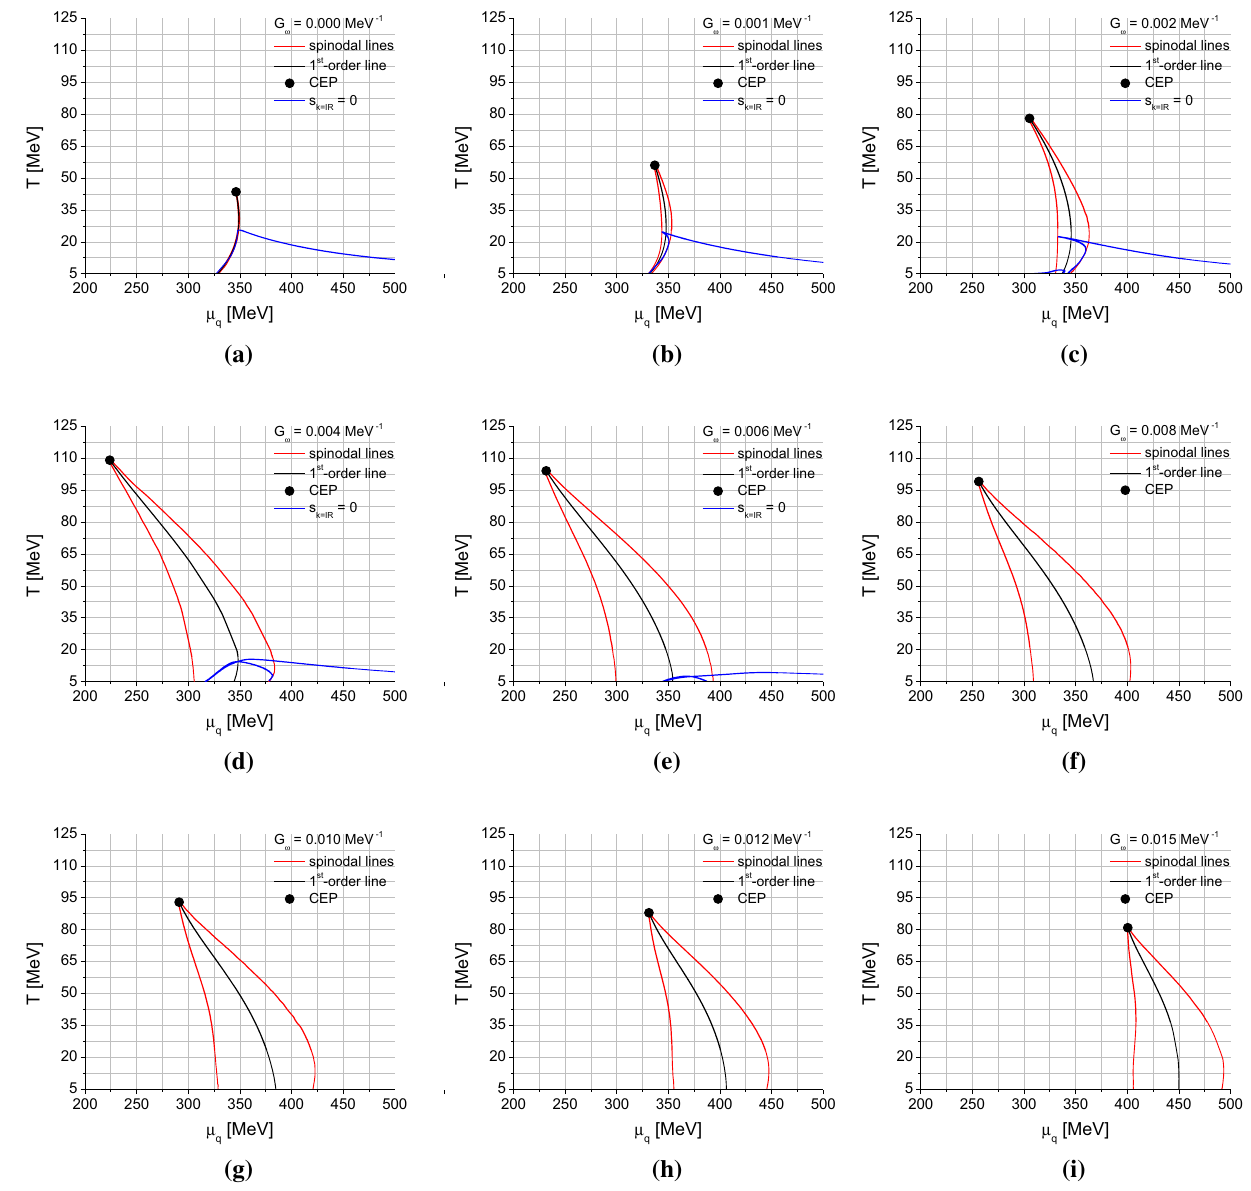
Fig. 3 First order phase transition of the QM model, for increasing values of G ω and fixed G ρ = 0. The red, black and blue lines are the spinodals, first order phase transition and the s k = IR = 0 lines, respec- sidering finite G ω . The first order phase transition line